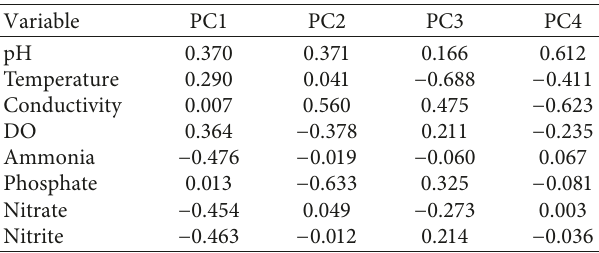
Table 3: Principal component analysis of surface water: pH, temperature, conductivity, dissolved oxygen, ammonia, reactive phosphate, nitrate, and nitrite.